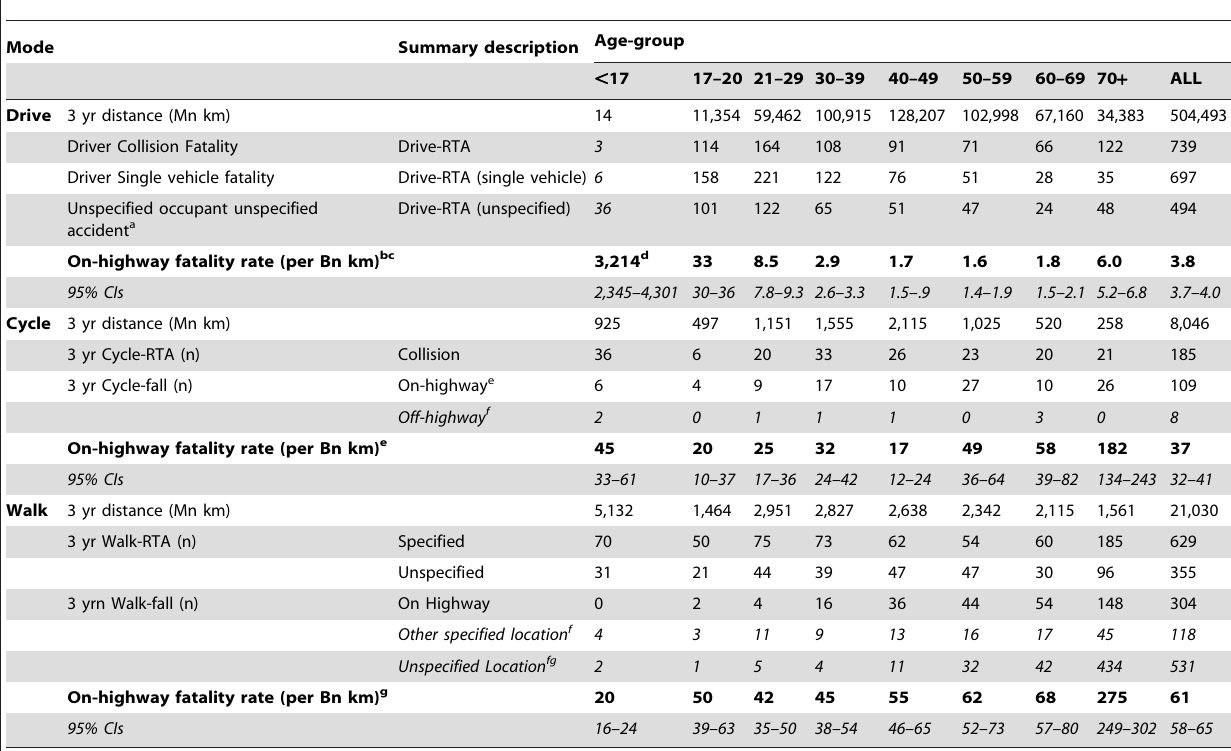
Table 1. Fatality numbers and rates per distance travelled, by travel mode, age, and type of incident, Males, England 2007–2009.